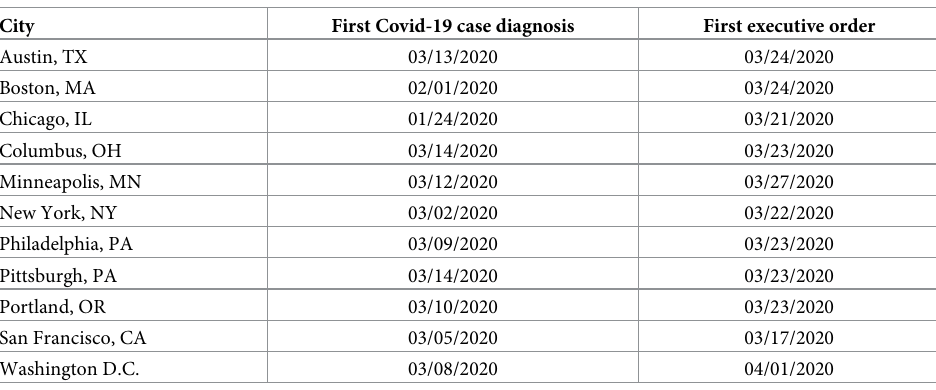
Table 1. Treatment start